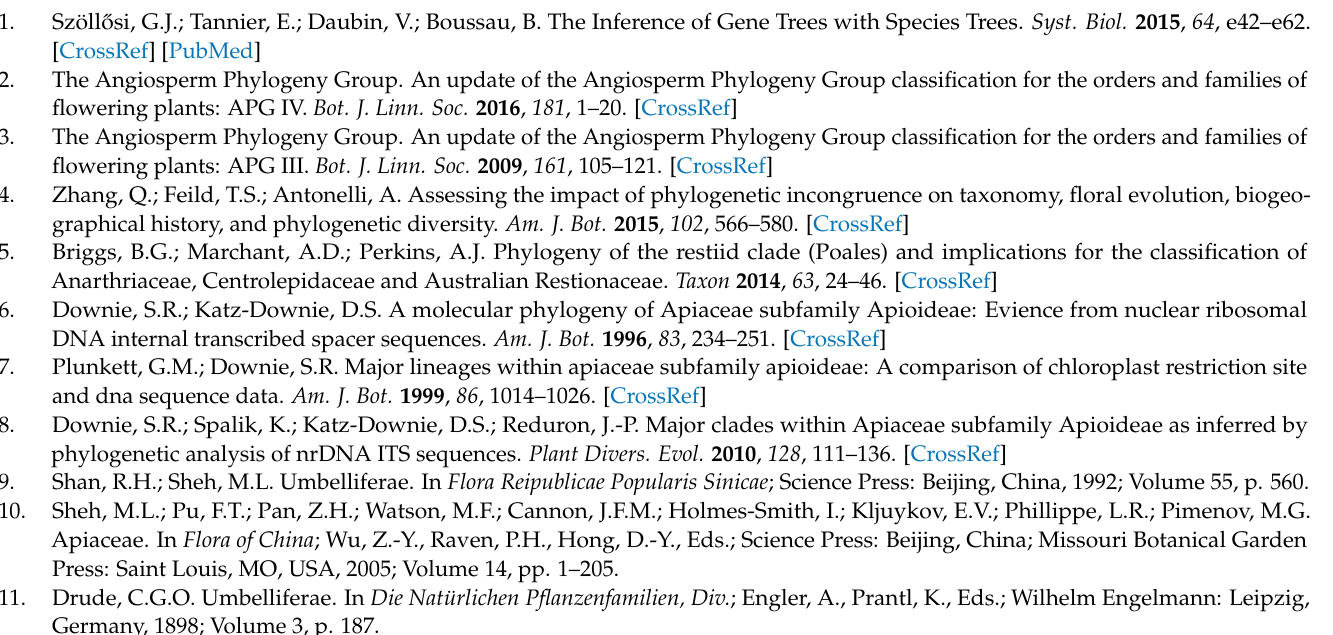
species; Table S2: Voucher details and GenBank accession numbers of taxa sequenced in this study; Table S3: Number of SSR types and SSRs’ distribution; Table S4: Repeat units of SSR types; Table S5: Nucleotide diversity analyses of Ostericum and Angelica